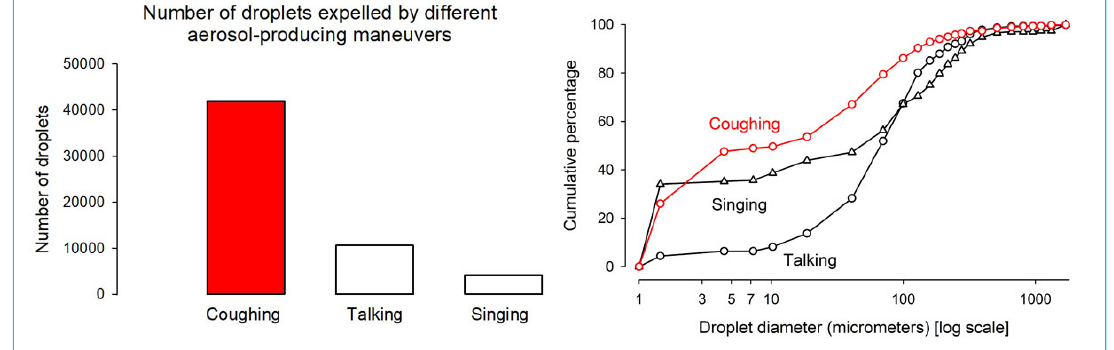
Figure 2: Comparative quantity of droplets produced by three respiratory manoeuvres (left) and cumulative proportional distribution of the sizes of expelled droplets by type of respiratory manoeuvre (right). Figure constructed from Loudon’s data [8], used with the permission of the publisher. The authors, editors, and The American Thoracic Society are not responsible for errors or omissions in adaptations. 1 μm [microme- ter] = 0.001 mm